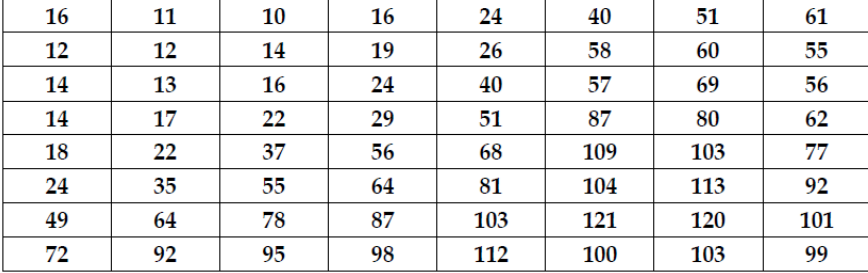
Figure 2. The standard quantization table for luminance components.